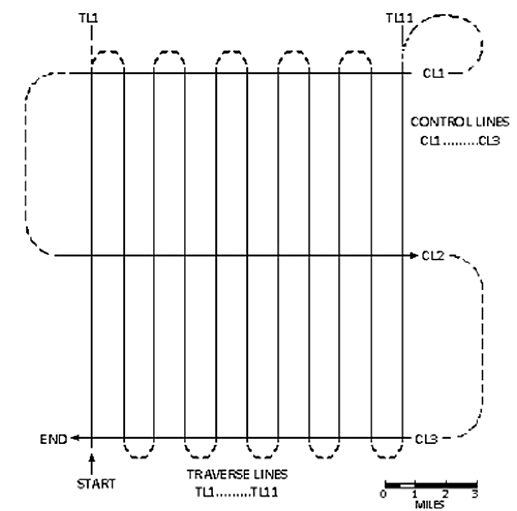
Figure 17. Representation of the control and provisional acquisition lines (source: W. Urquhart, 2013, http://www.geoexplo.com/flight_ plan.gif, last access: October 2014, reprinted with permission as per